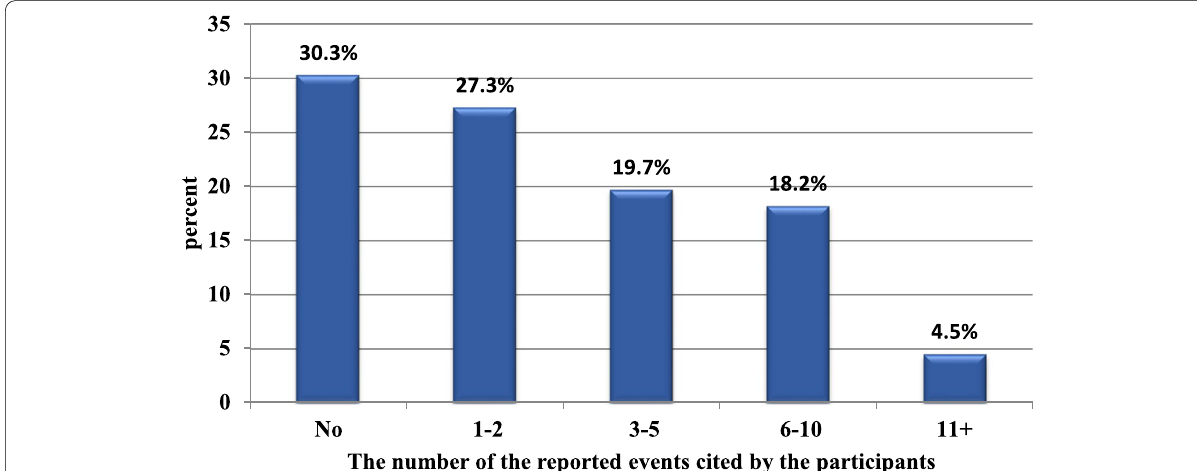
Fig. 1 The number of the reported events cited by the participants at the University Hospital for Gynecology and Obstetrics, Alexandria, Egypt, November 2020 to January